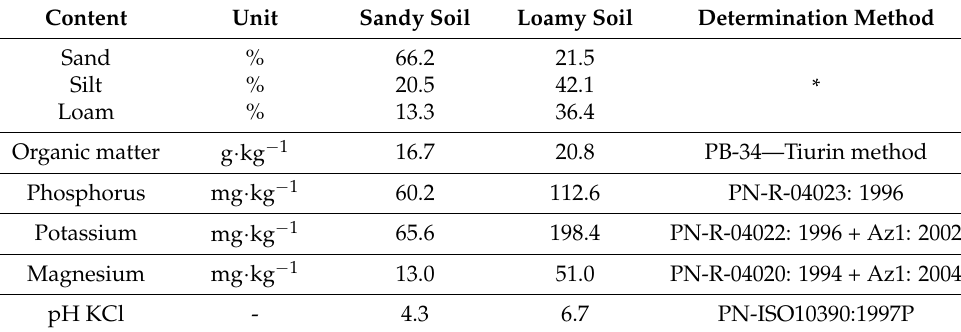
Table 1. Soil properties in the experimental plots (0–30